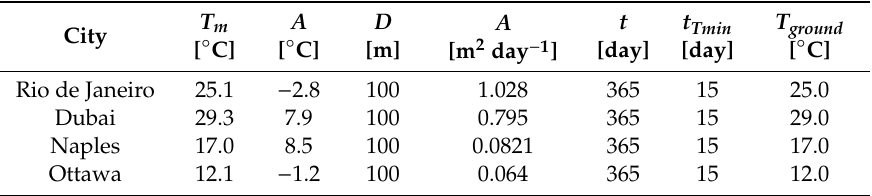
Table 5. Temperature of the soil obtained by Kusuda equation